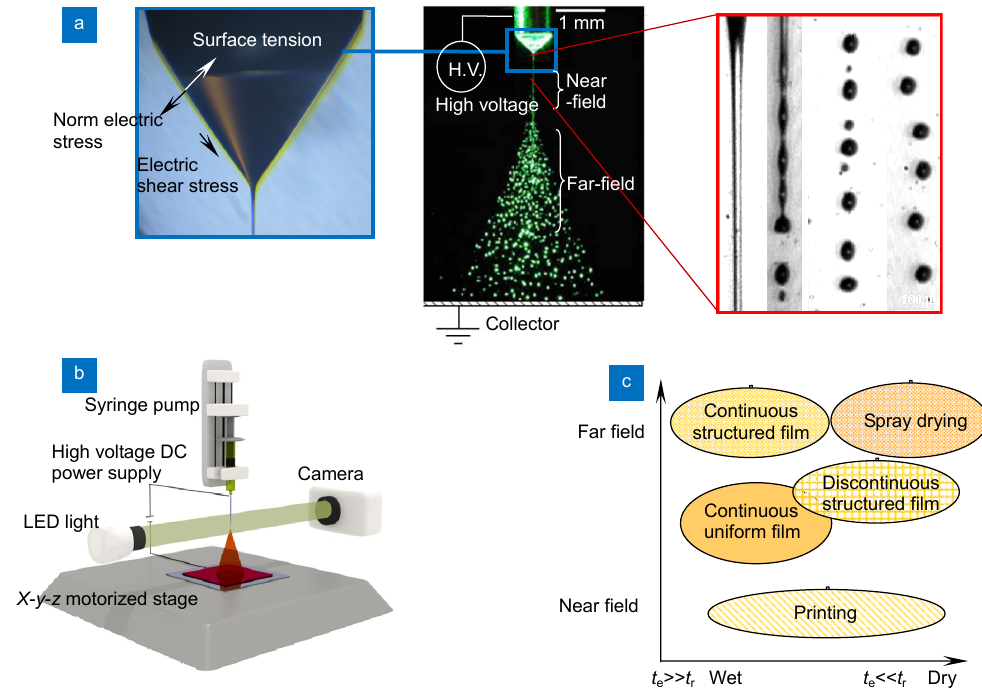
Fig. 1 | The electrospray and electrospray as a tool for material processing. (a) A close-up view of the Taylor cone with a fine jet attached to the cone, and the jet diameter is typically 10 to 10 4 nm, and details of the break-up process 31 . (b) A typical arrangement of the electrospray. (c) Several typical outcomes of using electrospray as a material processing tool.